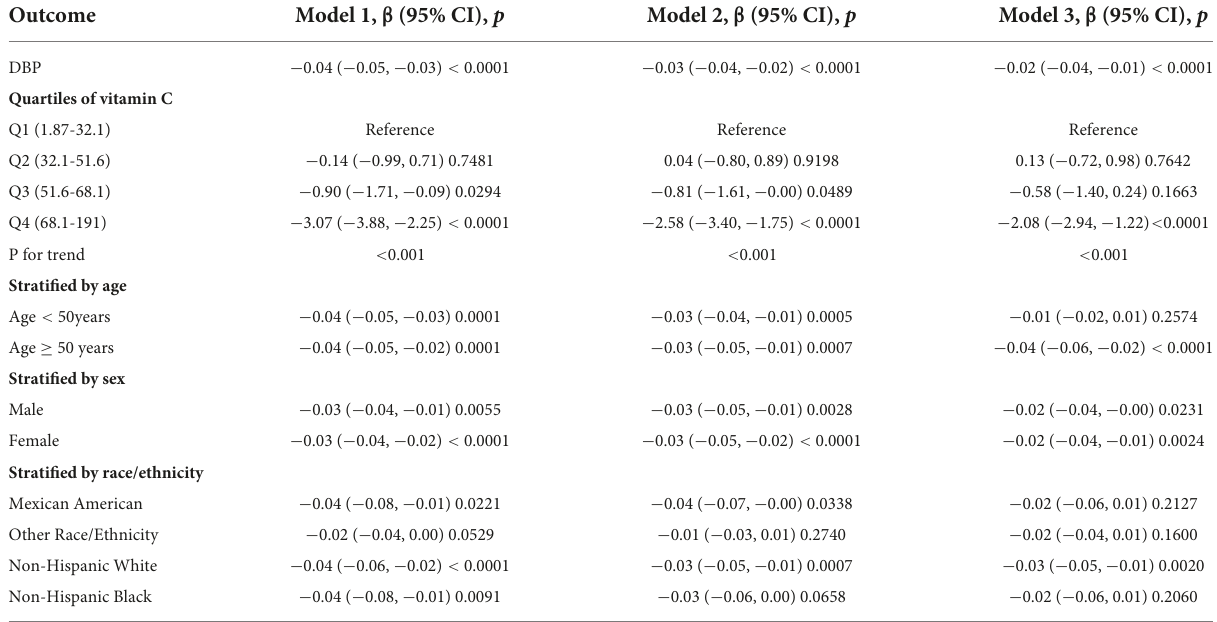
TABLE 3 Association between serum vitamin C (umol/L) and DBP (mmHg).